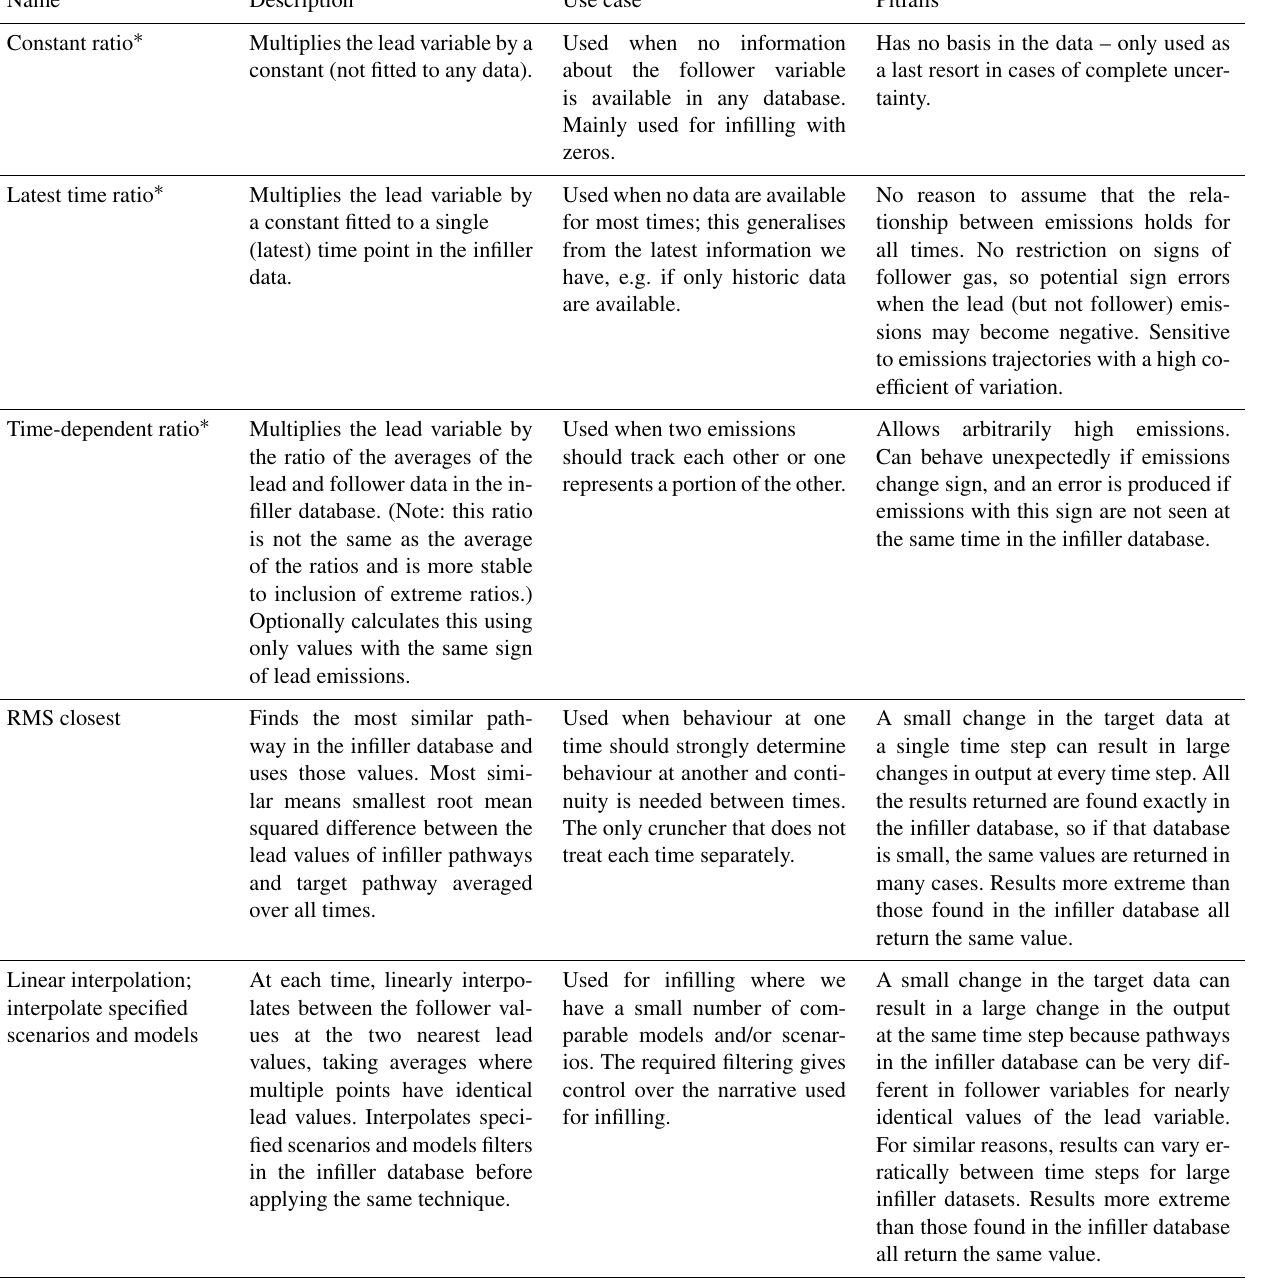
Table 1. A guide to crunchers. Names followed by asterisks use a ratio-based approach; i.e. they find a multiplicative factor and then multiply the target lead by this value. These crunchers do not preserve harmonisation. If the asterisk is in brackets, a ratio-based approach is optional. Otherwise, techniques all return linear combinations of values seen in the infiller